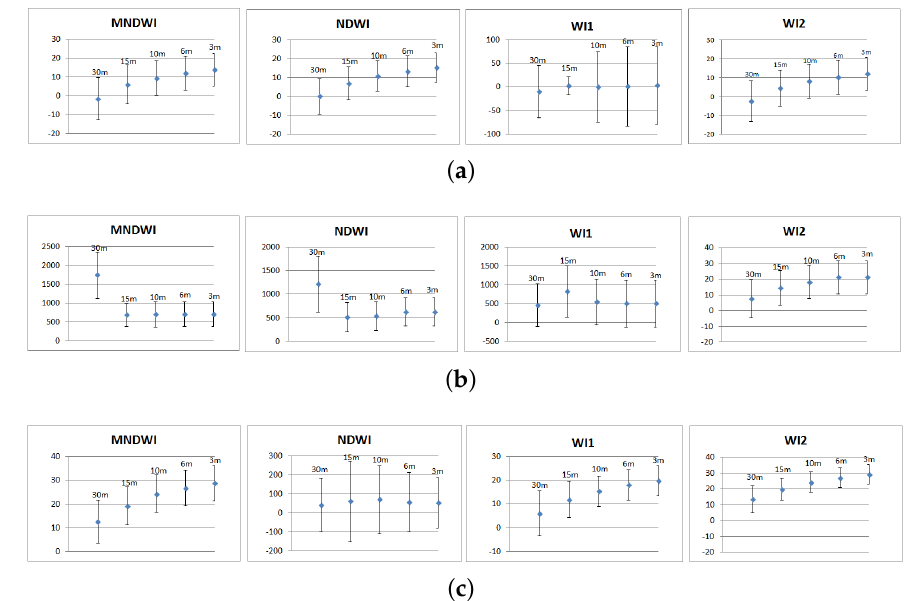
Figure 18. The graphs show the mean distance and standard deviation behavior according to the different factor of bicubic interpolation used on the Landsat images to analyze accuracy assessment in the coastline detected in Adra river delta. ( a ) The image captured on 18 July 2010. ( b ) The image captured on 23 May 2013. ( c ) The image captured on 2 July 2016.